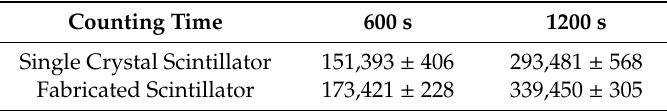
Table 13. Scintillator efficiency to counting time.